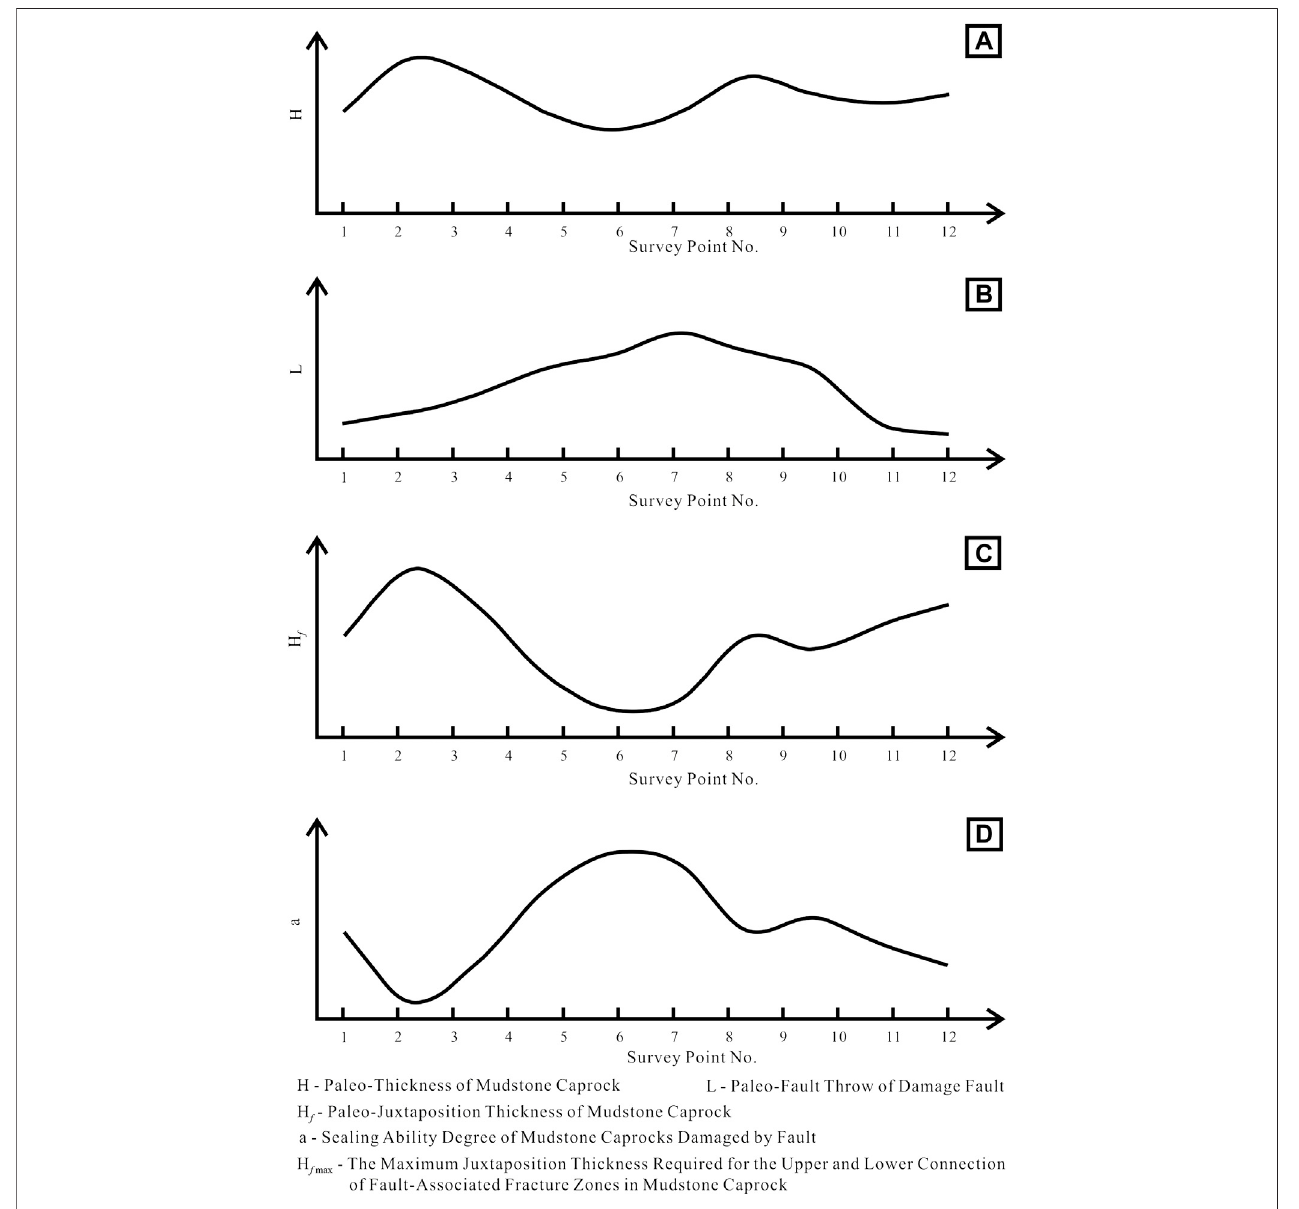
FIGURE 5 | Diagram of the determination of sealing degree distribution of regional mudstone caprocks damaged by fault during the hydrocarbon accumulation period. (A) Paleo-thickness of regional mudstone caprock; (B) Paleo-fault throw of damage fault; (C) Paleo-juxtaposition thickness of regional mudstone caprock; (D) Sealing ability degree of regional mudstone caprocks damaged by